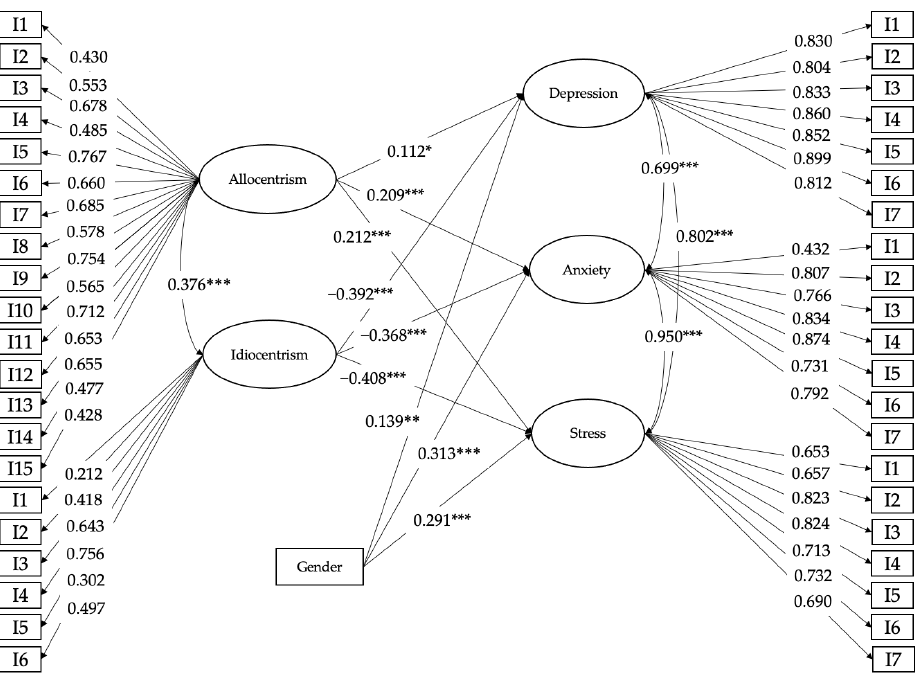
Figure 1. Model of theoretical associations between allocentrism and idiocentrism with depression, anxiety, and stress, together with gender control variables. For greater simplicity of the model, other non-significant control variables were not plotted. * p ≤ 0.05, ** p ≤ 0.01, and *** p ≤ 0.001.